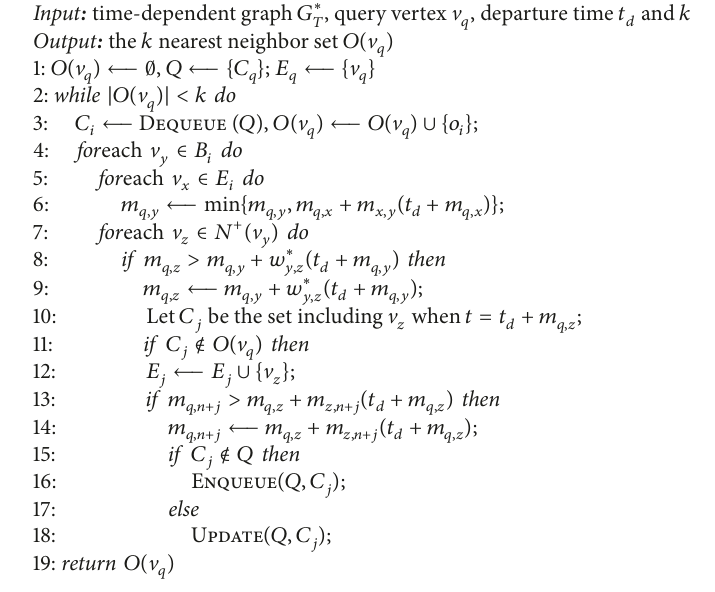
Algorithm 2: kNN-Query ( 𝐺 ∗ 𝑇 , V 𝑞 , 𝑡 𝑑 ,𝑘